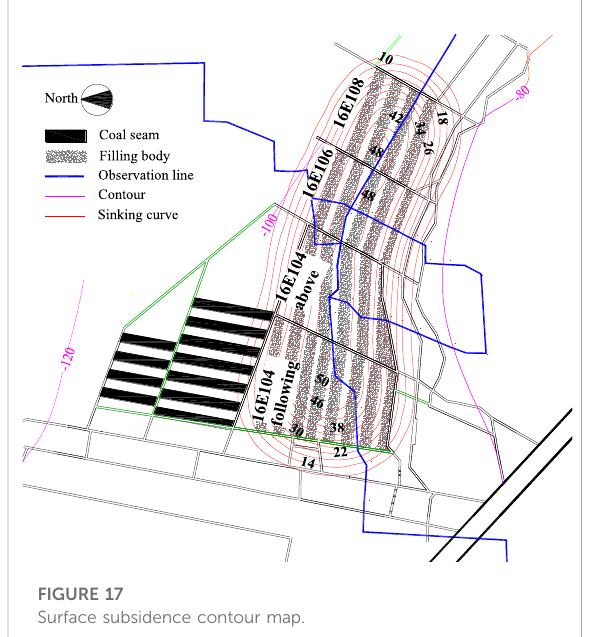
FIGURE 17 Surface subsidence contour